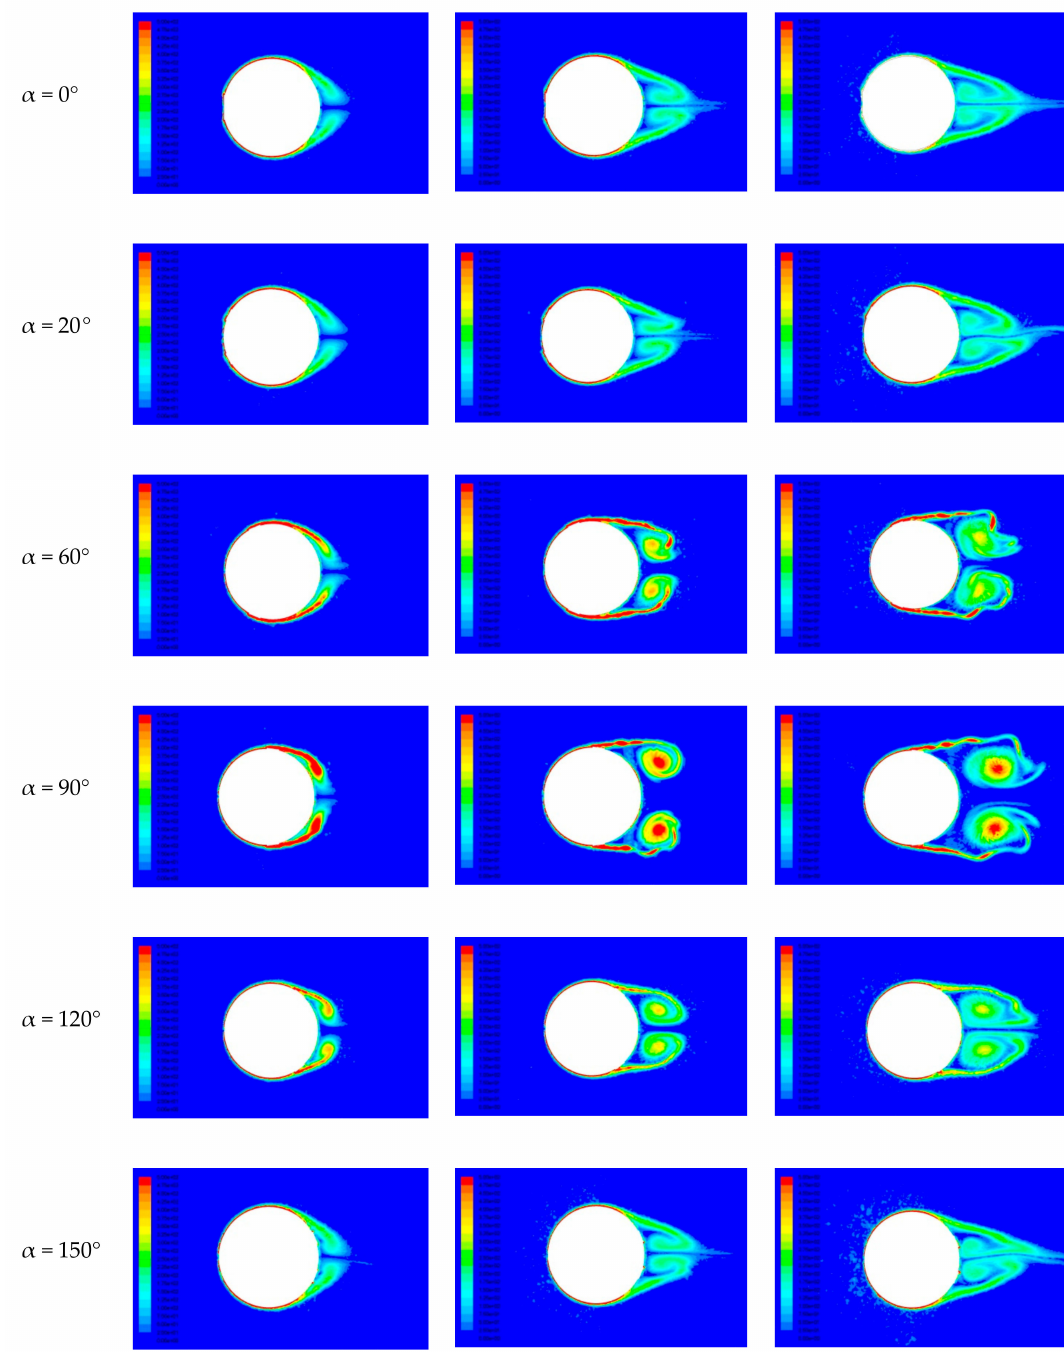
Figure 9. The vorticity contours of the wake flow for di ff erent locations of strips for Re =